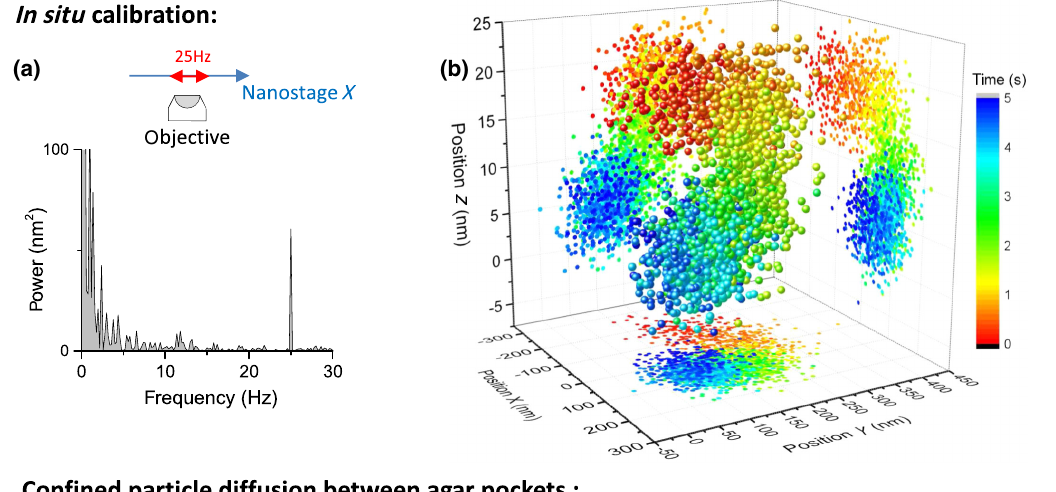
10 s), indicating constrained diffusion. The traces were analyzed by calculating the mean square displacement (MSD) as a function of time lag ( t ) [1]. Histograms of lag the displacement for different t are shown in Fig. 7(e). lag